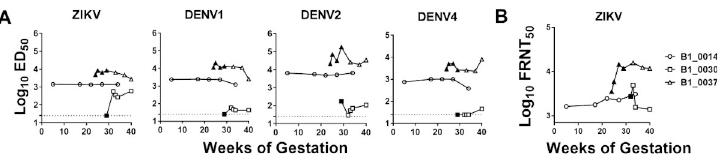
Fig 3. ZIKV binding and neutralizing IgG responses persist throughout pregnancy. A. Maternal plasma collected serially from three women diagnosed with ZIKV during pregnancy was assessed for IgG binding responses to ZIKV via virion capture ELISA. The estimated dilution at 50% of maximal binding (ED 50 ) was calculated from serial dilutions of maternal plasma. Black filled points indicate time points when ZIKV viremia was detected by RT-PCR. B. ZIKV focus reduction neutralization titer throughout pregnancy.